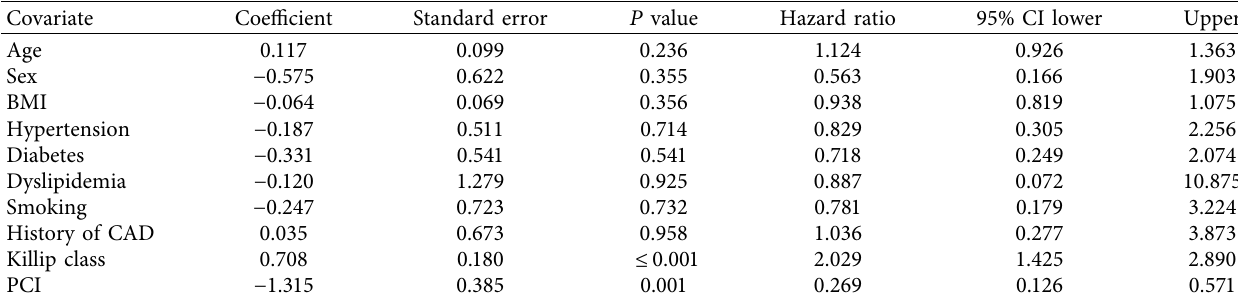
Table 4: Results of multivariate Cox regression model.